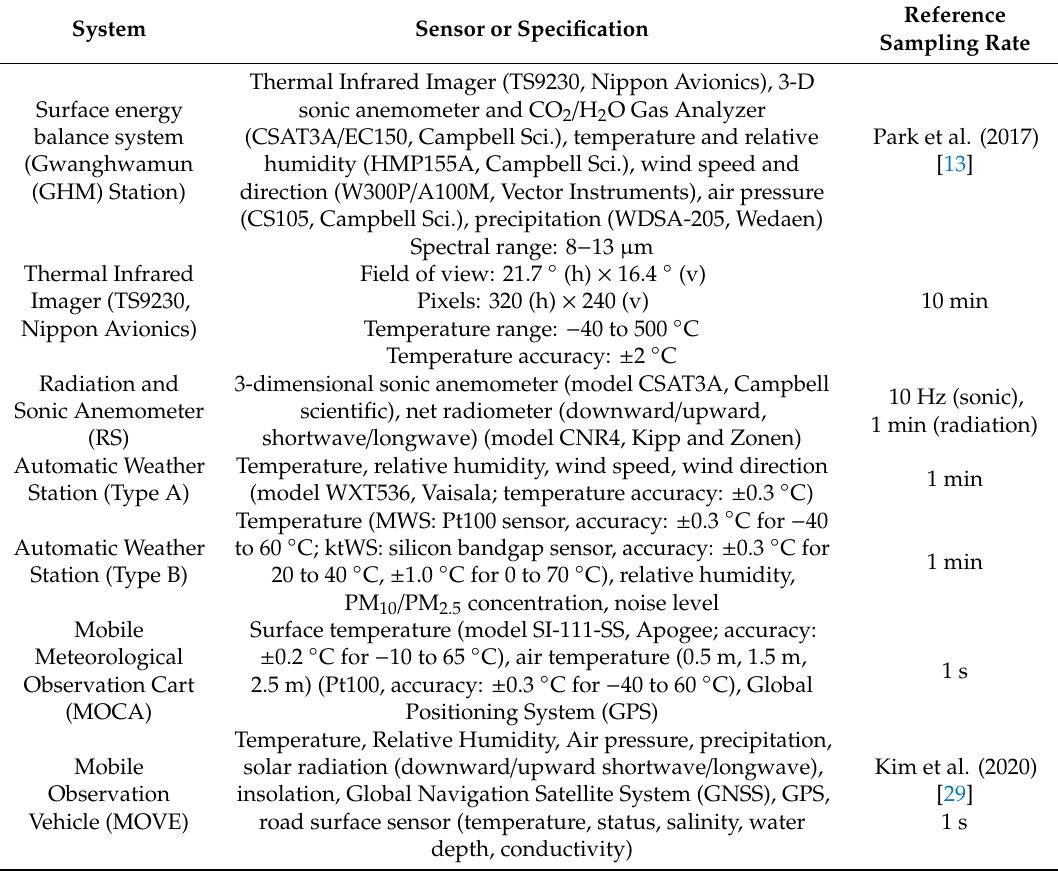
Table 2. Specification of main instruments